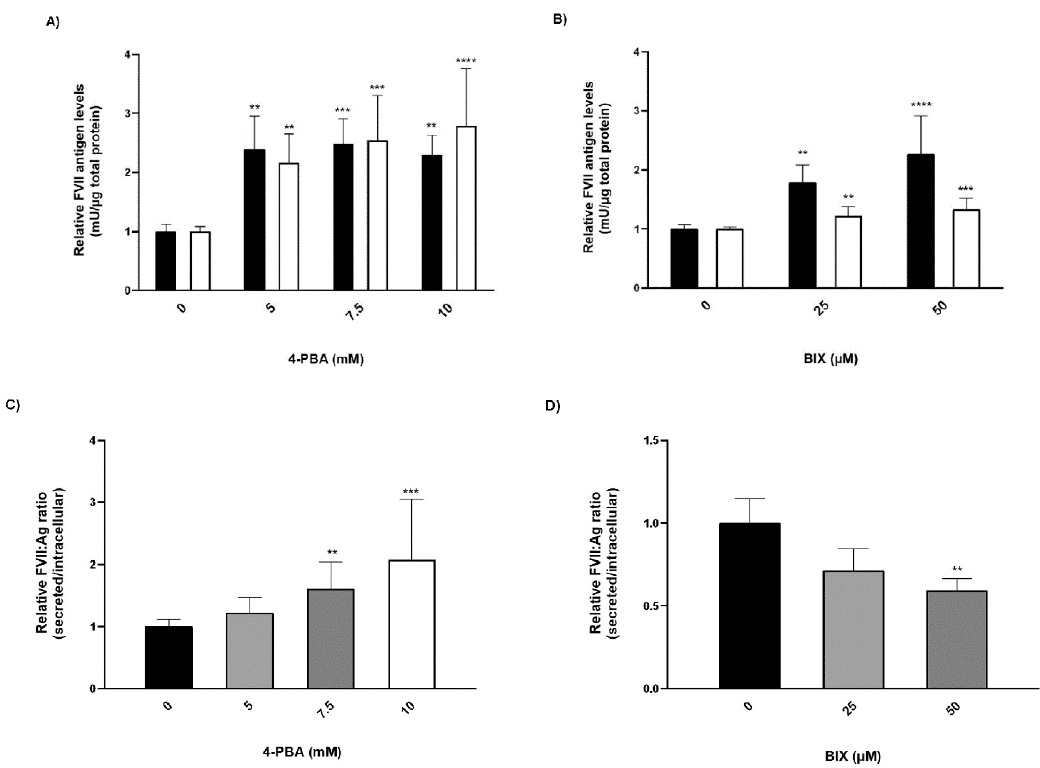
Figure 3. The effect of chaperone treatment on FVII variant production and secretion. Cells with stable expression of rFVII- 354V-464Hfs were treated with 4-PBA or BIX for 48 h. ( A , B ) FVII:Ag levels in medium (white bars) or cell lysates (black bars). To adjust for variations in cell number, the FVII:Ag levels were adjusted to the corresponding total protein content in the respective wells. (one-way ANOVA, **** p ≤ 0.0001, *** p ≤ 0.001, ** p ≤ 0.01). ( C , D ) Ratio between the secreted versus intracellular FVII:Ag. Values are expressed relative to untreated cells and are reported as mean ± SD from at least three independent experiments performed in duplicate (**** p ≤ 0.0001, *** p ≤ 0.001, ** p ≤ 0.01; one-way ANOVA).